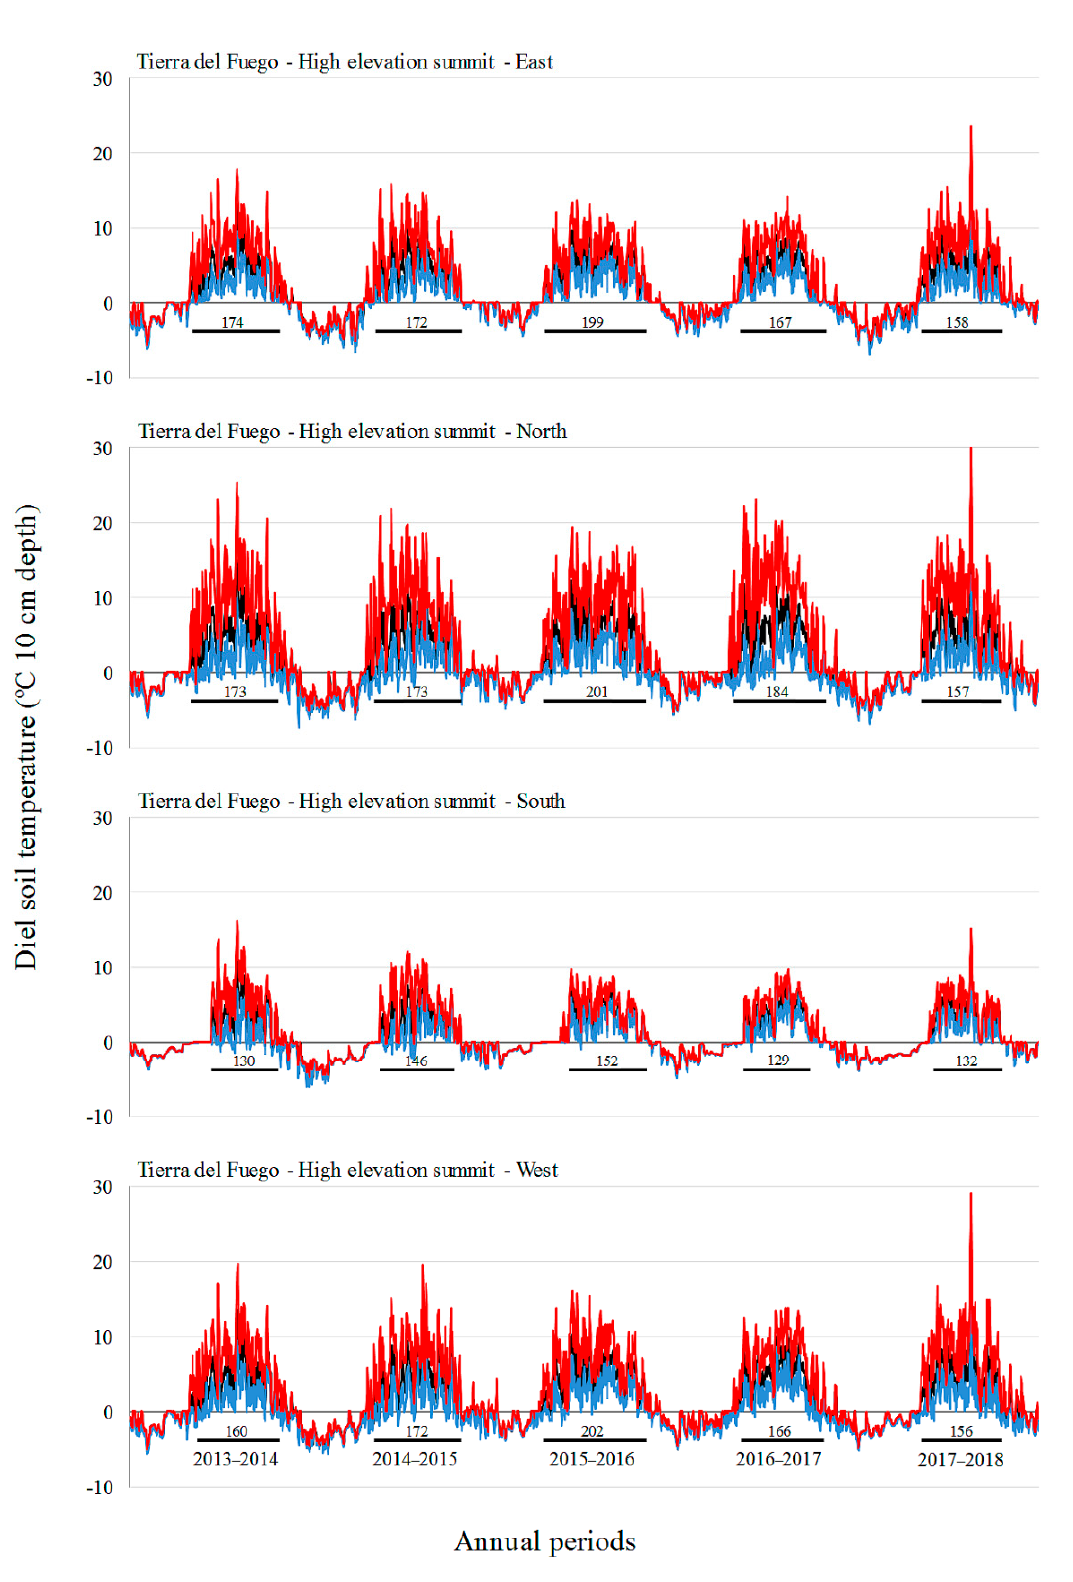
Figure A7. Diel soil temperature ( ◦ C) variation at 10 cm depth during the five studied annual periods (2013–2014 to 2017–2018) on high elevation summit in Tierra del Fuego, showing separately different cardinal aspects (east, north, south, west). The length of the growing season is also indicated with horizontal black bars (numbers represent days). Black = mean temperature; blue = minimum temperature, and red = maximum temperature.